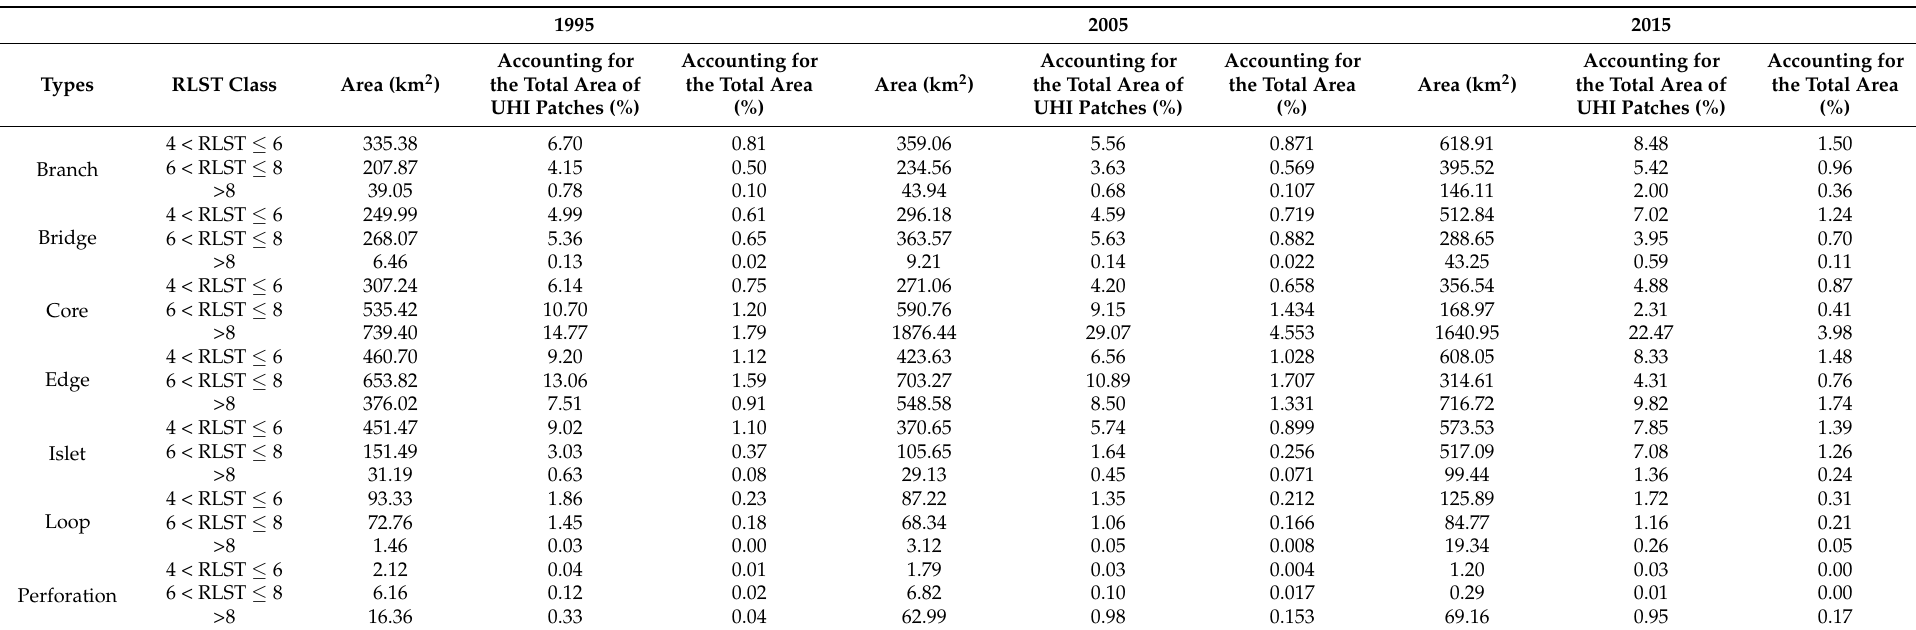
Table 2. MSPA-based classification and statistics results in different